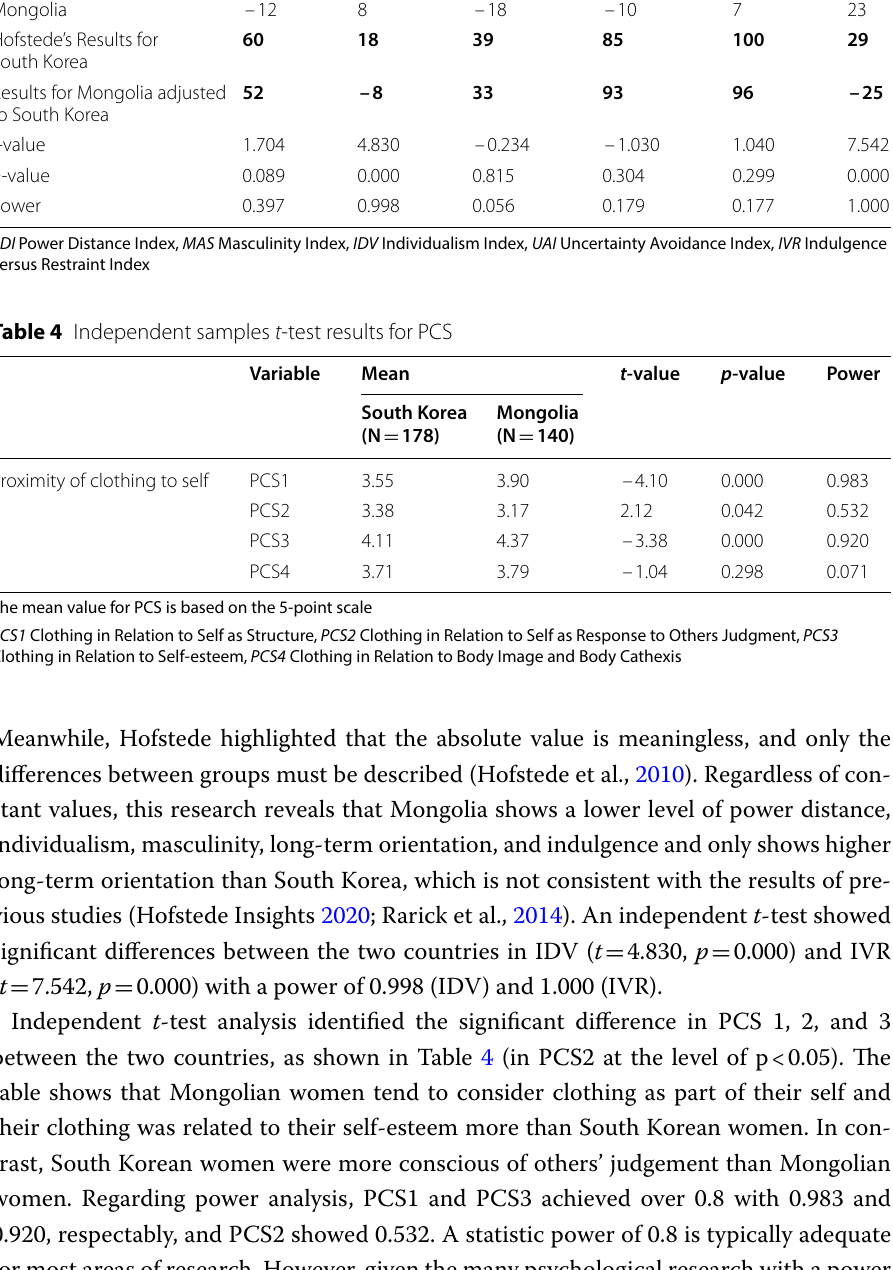
Table 3 Results for Cultural Values with a t -test and power analysis